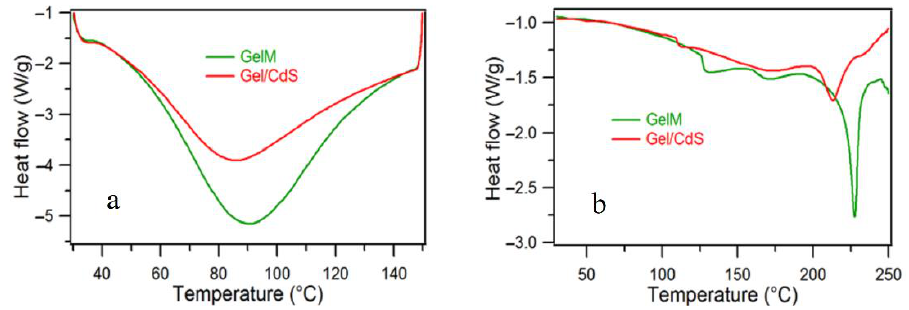
Figure 5. DSC spectra of ( a ) 1st heating and ( b ) 2nd heating of gelatin and Gel/CdS QDs.